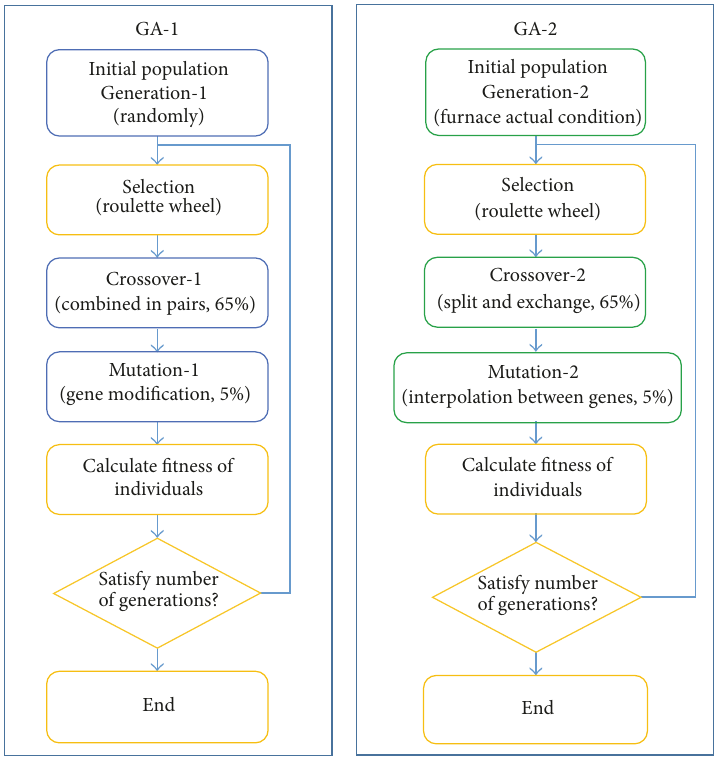
Figure 1: Flowcharts explaining the structure of GA-1 and